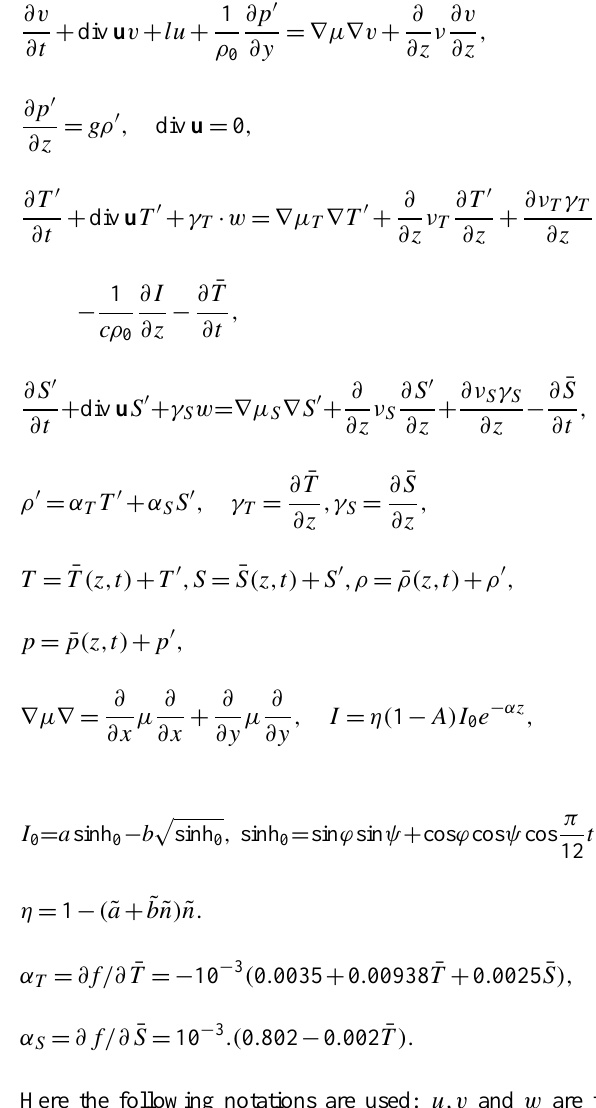
Fig. 18. The temperature fields (deg. C) on depth of 10 m predicted by BSM of MHI at 48 h (a) and 72 h (b) (forecasting period is 26.10.2010, 00:00 h – 29.10.2010, 00:00 h). 5